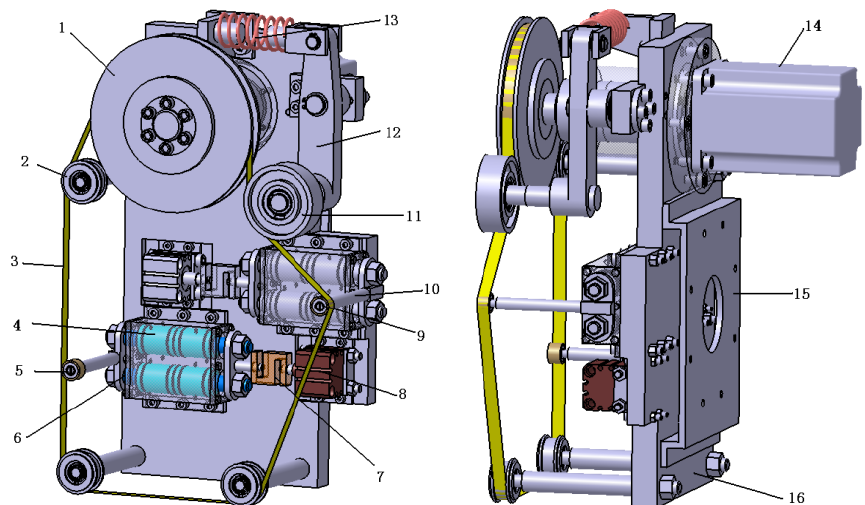
Figure 2. Structure drawing of the belt tool system. (1) Driving wheel. (2) Idler wheel. (3) Belt. (4) Linear bearing. (5) Contact wheel on the convex blade side. (6) Linear optical shaft. (7) S-shaped force sensor. (8) Cylinder. (9) Contact wheel on the concave blade side. (10) Shaft of the contact wheel. (11) Tension pulley. (12) Tension arm. (13) Tension compression spring. (14) Drive motor. (15) Flange. (16) Substrate for installation.